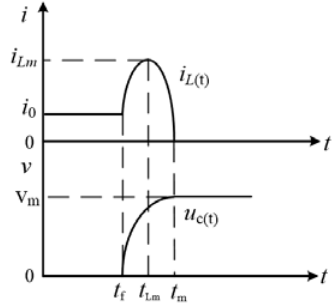
Figure 7. Capacitor voltage and inductance current curves.